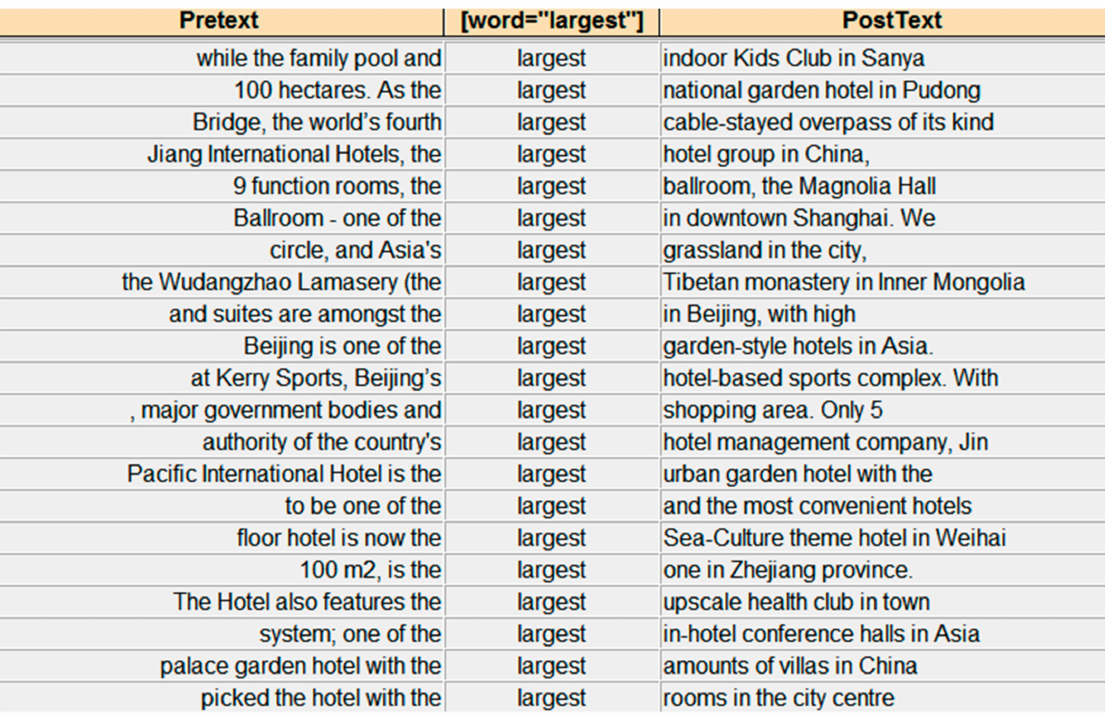
Figure 5. Examples of the use of “largest” in